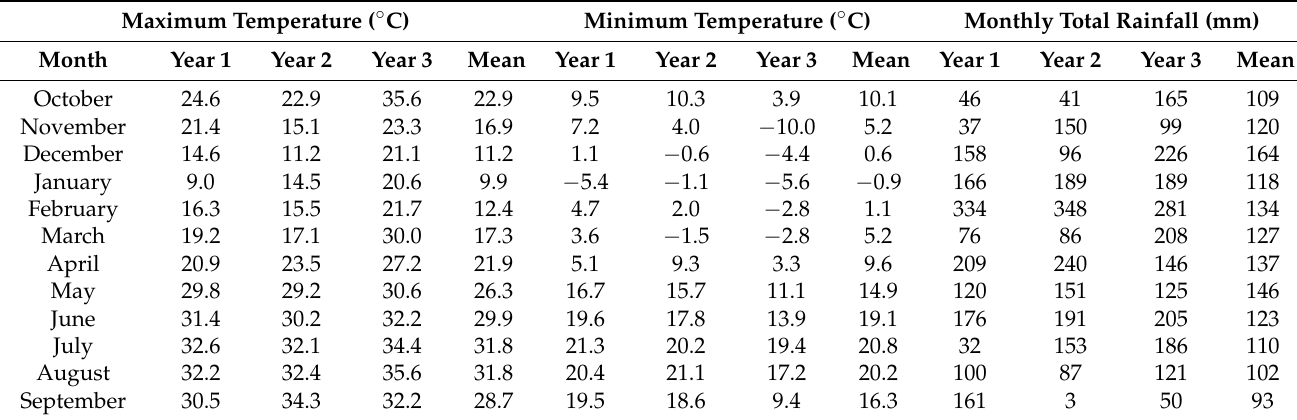
Table 1. Monthly mean maximum, minimum temperatures ( ◦ C) and rainfall for the first, second and third year of study and 30 year mean monthly normal temperature at Pontotoc,